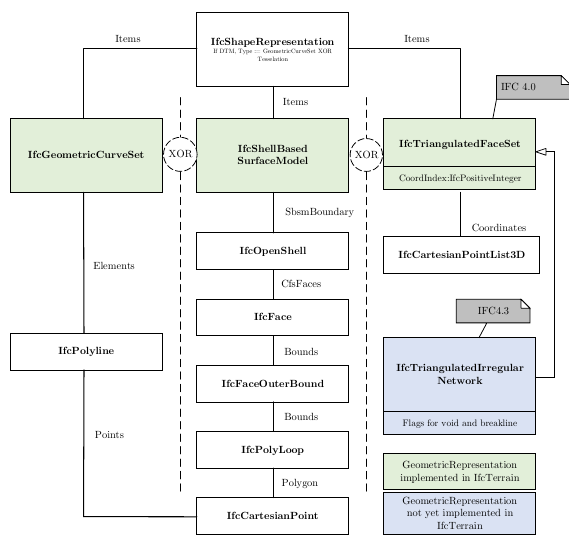
Figure 3. Concepts for Geometric Represenation that IfcTerrain is able to export.